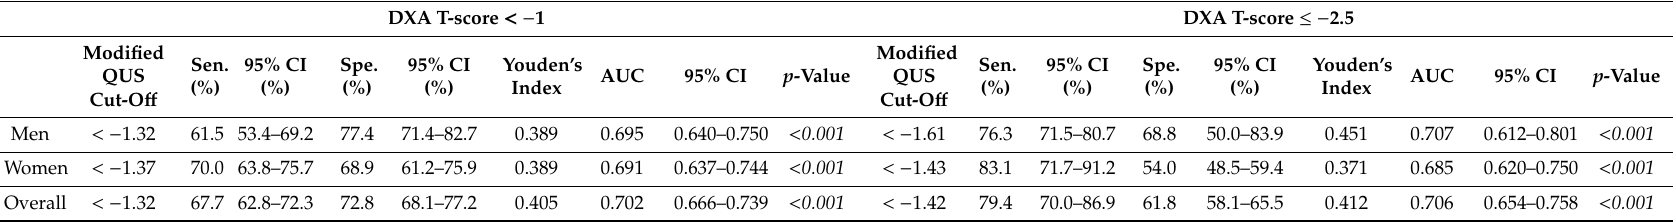
Table 5. Modified cut-o ff values of QUS T-scores for CM-200 according to sex in determining subjects with suboptimal bone health (DXA T-score < − 1) and osteoporosis (DXA T-score ≤ −